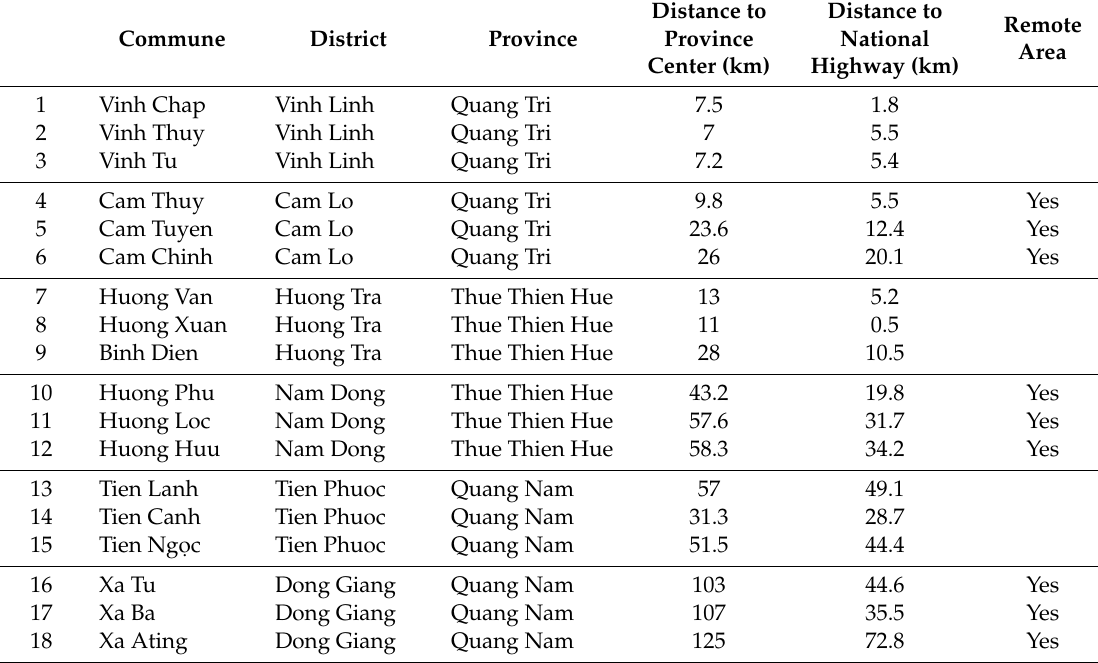
Table 2. Study site